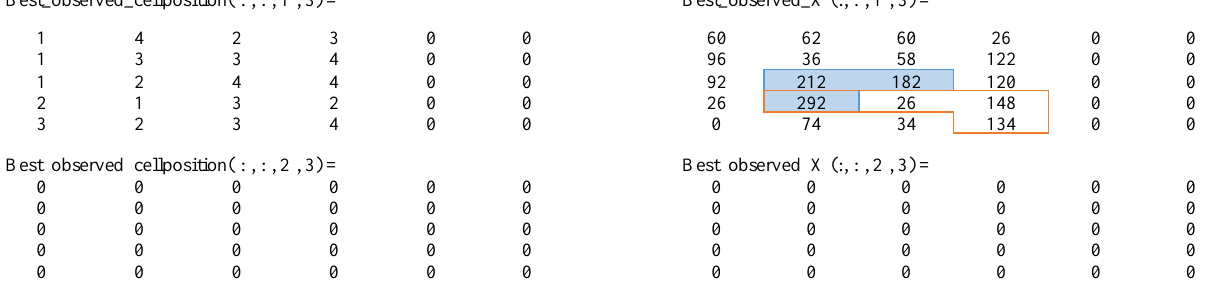
Fig. 23. Emerging complex dummy sub-cells after scheduling in a